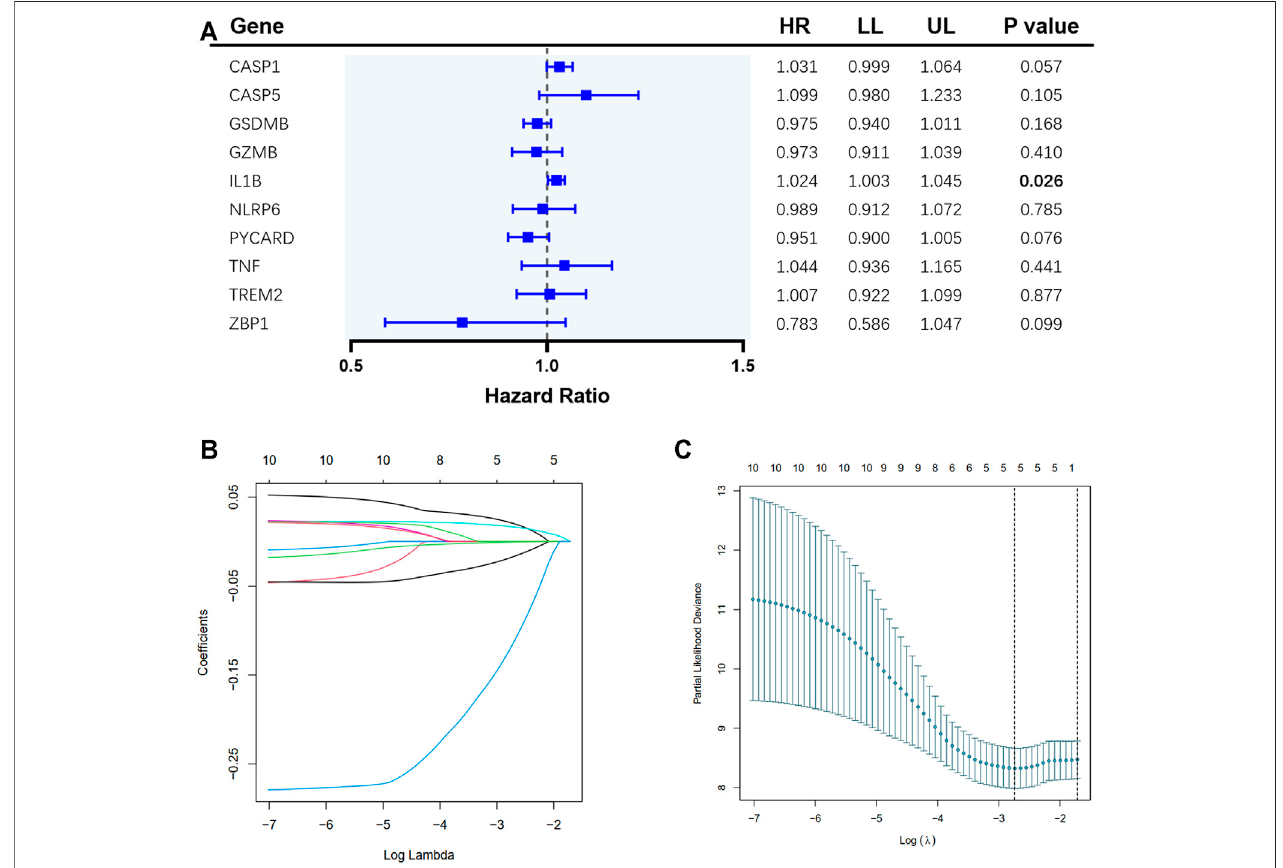
FIGURE2| Constructionofpyroptosis-relatedgenerisksignatureintheTCGAcohort. (A) UnivariateCoxregressionanalysisofoverallsurvival(OS)fortheselected genes. (B) LASSO regression of the 10 selected genes. (C) Cross-validation for tuning the parameter selection in LASSO regression.